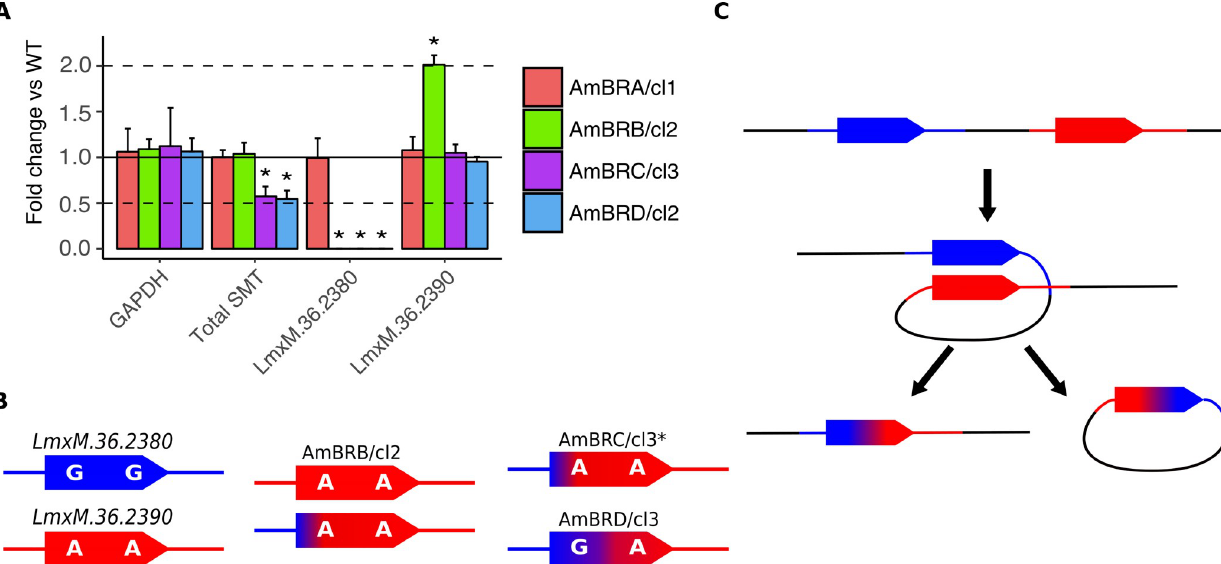
Fig 5. Genomic changes at the SMT locus. A) Copy number variations in GAPDH ( LmxM . 36 . 2350 )and SMT genes ( LmxM . 36 . 2380 and LmxM . 36 . 2390 ) as determined by qPCR. Fold changes are calculated as 2 - δ Ct between each line and wild-type, with 5 ng genomic DNA loaded per sample. Asterisks denote statistically significant differences (P < 0.05) in δ Ct from wild-type, n = 3. Dotted lines denote a halving or doubling of gene copy number. P values for statistically significant changes are as follows: for total SMT, values are 0.00302 and 0,00256 for AmBRC/cl3 and AmBRD/cl2, respectively; for LmxM . 36 . 2380 , values are 1.52 x 10 − 5 , 5.78 x 10 − 6 and 4.39 x 10 − 4 for AmBRB/cl2, AmBRC/cl3 and AmBRD/cl2, respectively; for LmxM . 36 . 2390 , the value for AmBRB/cl2 is 0.00105. See Methods for the statistical approach used. B) Transcript sequences present in wild type (left column) and resistant lines. C) A model for deletion of the intergenic region and formation of a chimaeric SMT gene copy. Homologous recombination leads to generation of an extrachromosomal circular fragment, which is subsequently lost during replication.